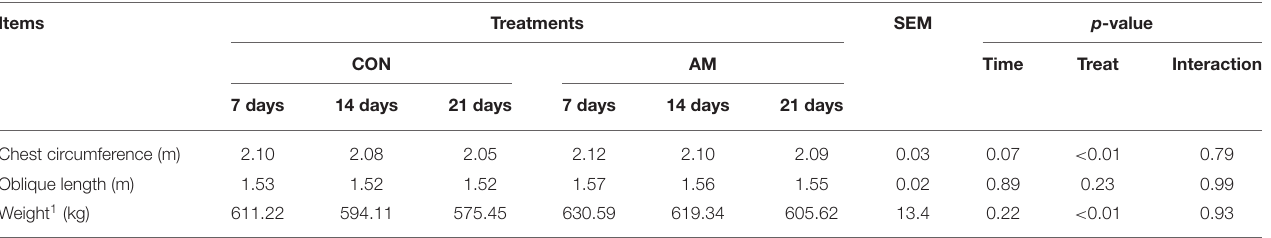
TABLE 3 | Effects of AM on body condition of dairy cows in perinatal